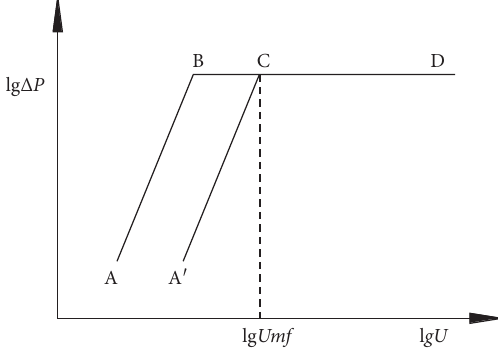
Figure 2: The relationship between Δ p and U in the ideal fluidized bed.